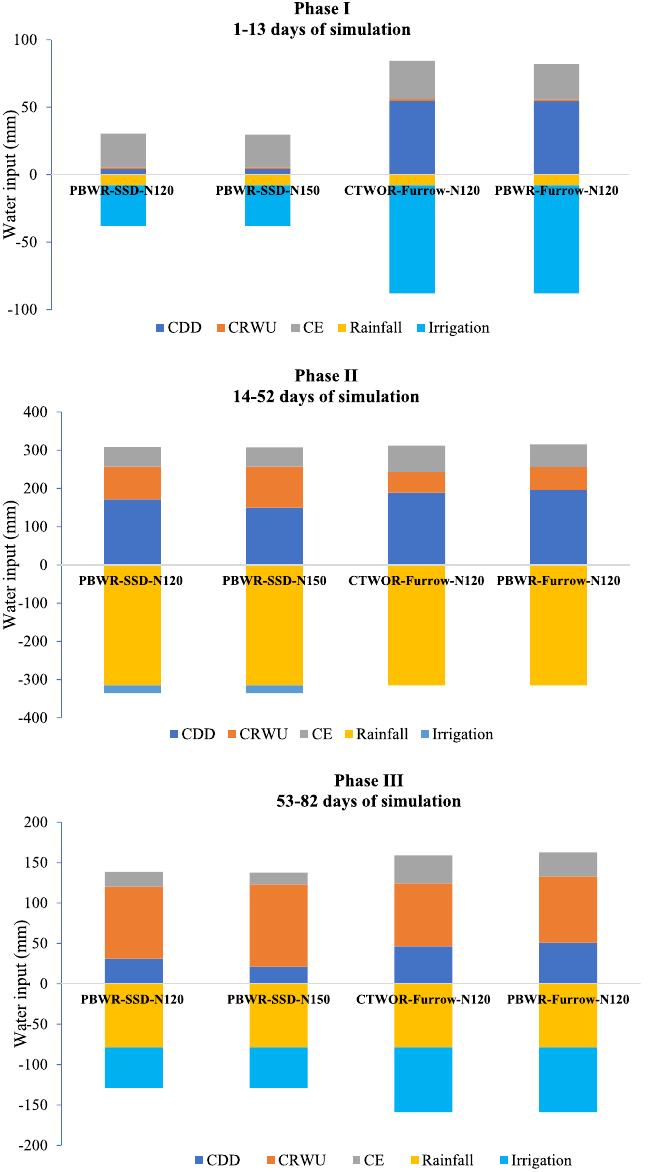
Figure 5. Partitioning of water input and output components in maize under contrasting tillage, residue, N and irrigation management treatments. Where, CDD: cumulative deep drainage; CRWU: cumulative root water uptake; CE: cumulative evaporation. Units of all parametersare in mm. *For treatment detail please see Table